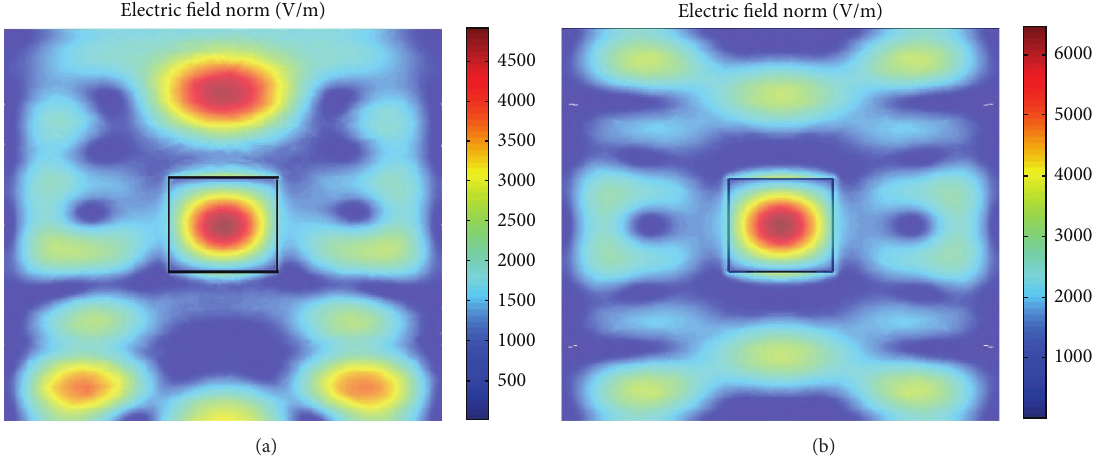
Figure 3: Surface plots of microwave electric field distribution for (a) single-source and (b) double-source microwave ports.